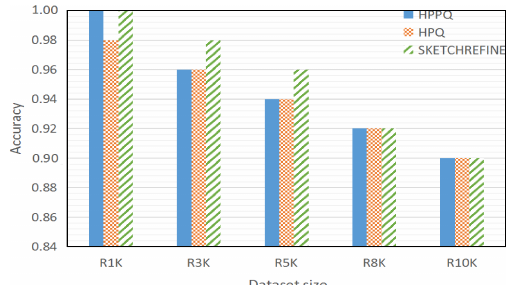
Fig. 5 Accuracy rate of different sizes of real-world dataset.